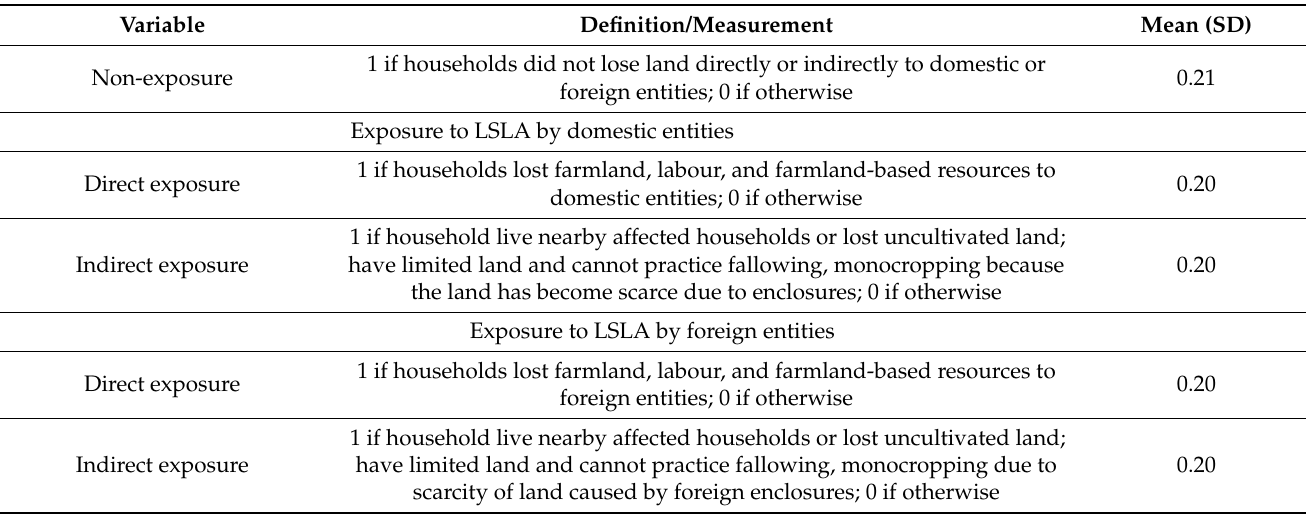
Figure 2. Overview of the study area. Note: The orange ‐ colored circles represent the location of the respondent during the interview, while the figure in the orange ‐ colored circles represent the number interviewed at that particular location. Source: Field Survey,